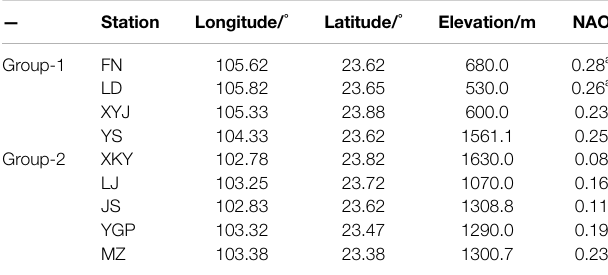
TABLE 9 | Correlation between winter precipitation and NAO Index at rainfall station. —